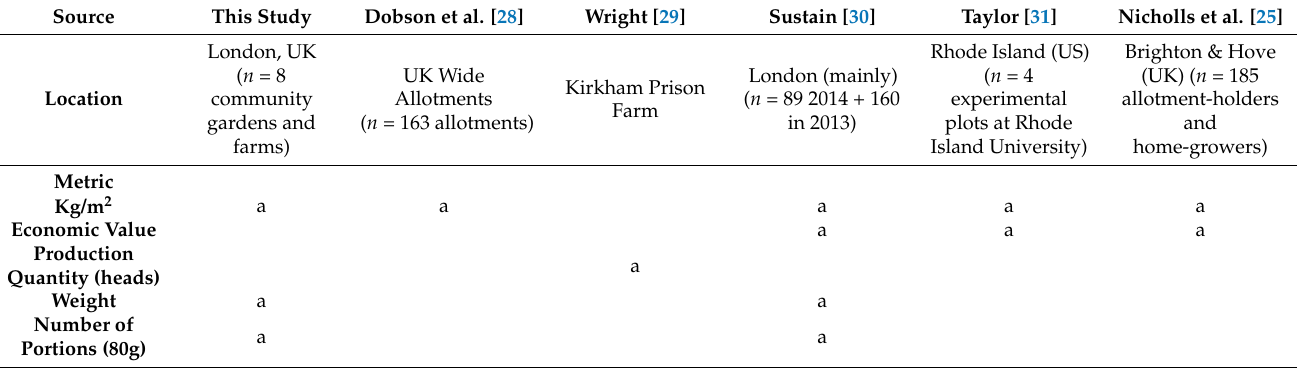
Table 1. A selection of approaches to measure UA crop productivity used in recent